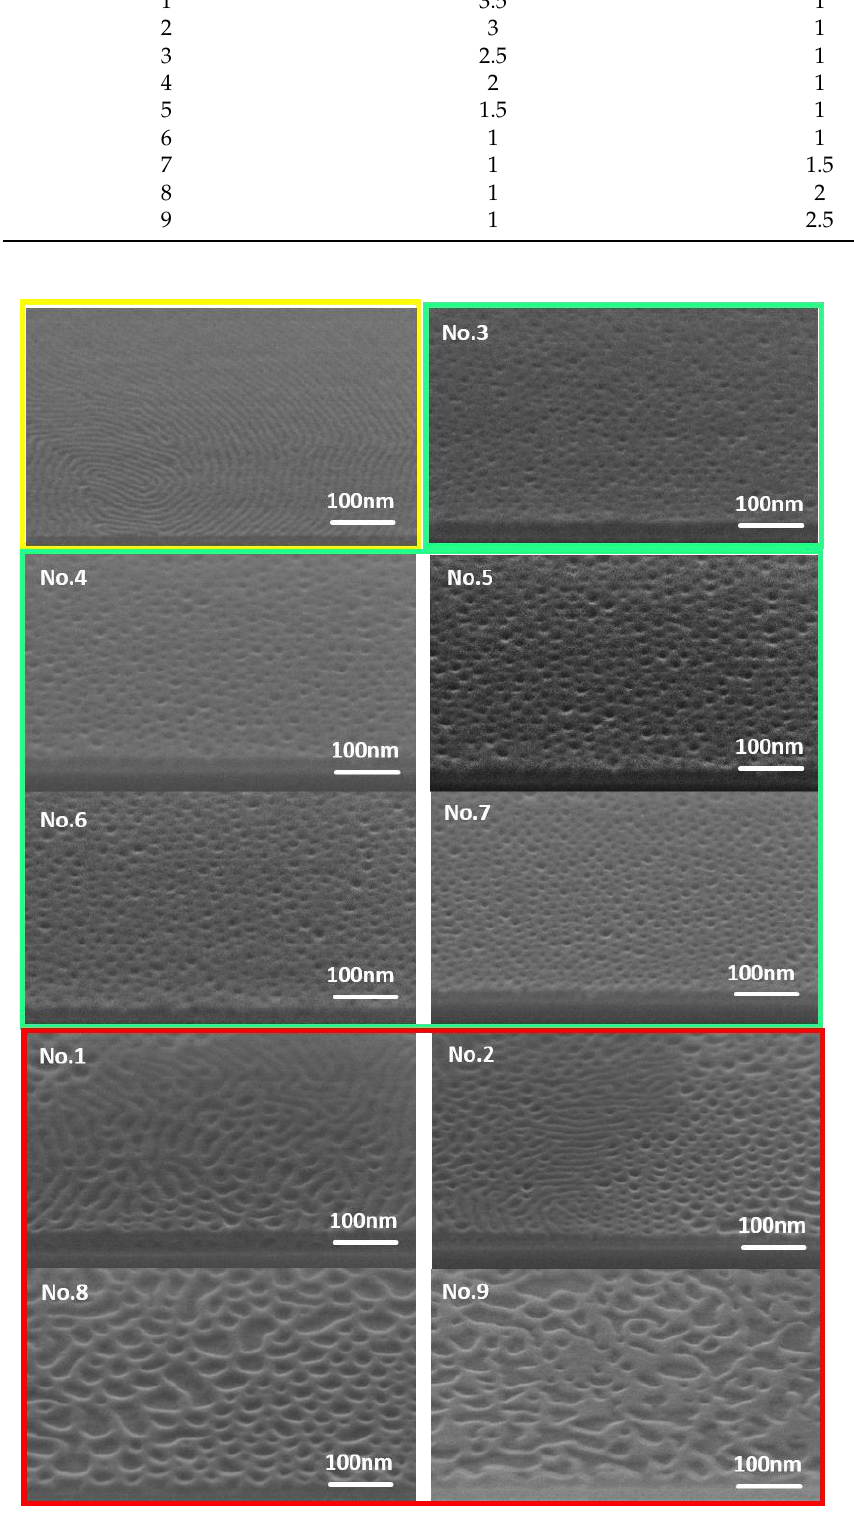
Figure 3. SEM images of blend phase separation results. The annealing temperature is 130 °C, and the annealing time is 30 min. The thickness of blend materials is about 20 nm. The vacuum degree is −0 .1 MPa.